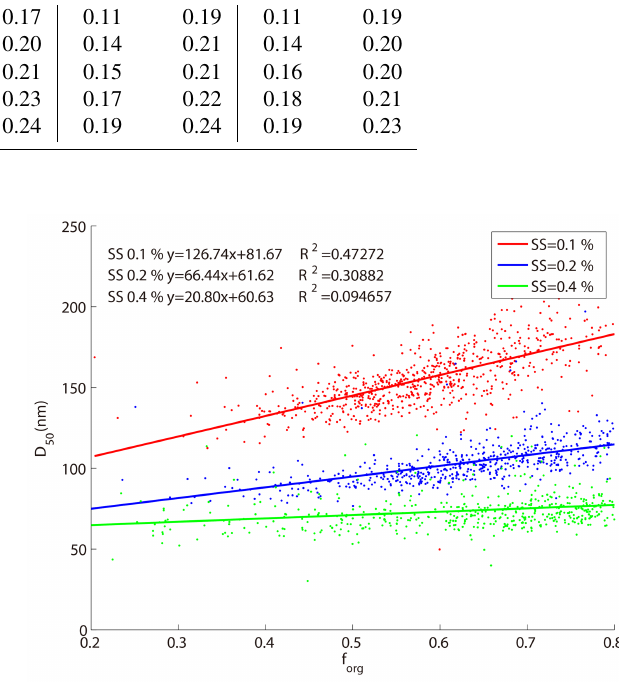
Table 3. The average of σ values of Gf-PDF measured by the HTDMA for five diameters for the steep and smooth activation ratio at four supersaturations. SS (%) 0.1 Steep Smooth Steep Smooth Steep Smooth Steep Smooth